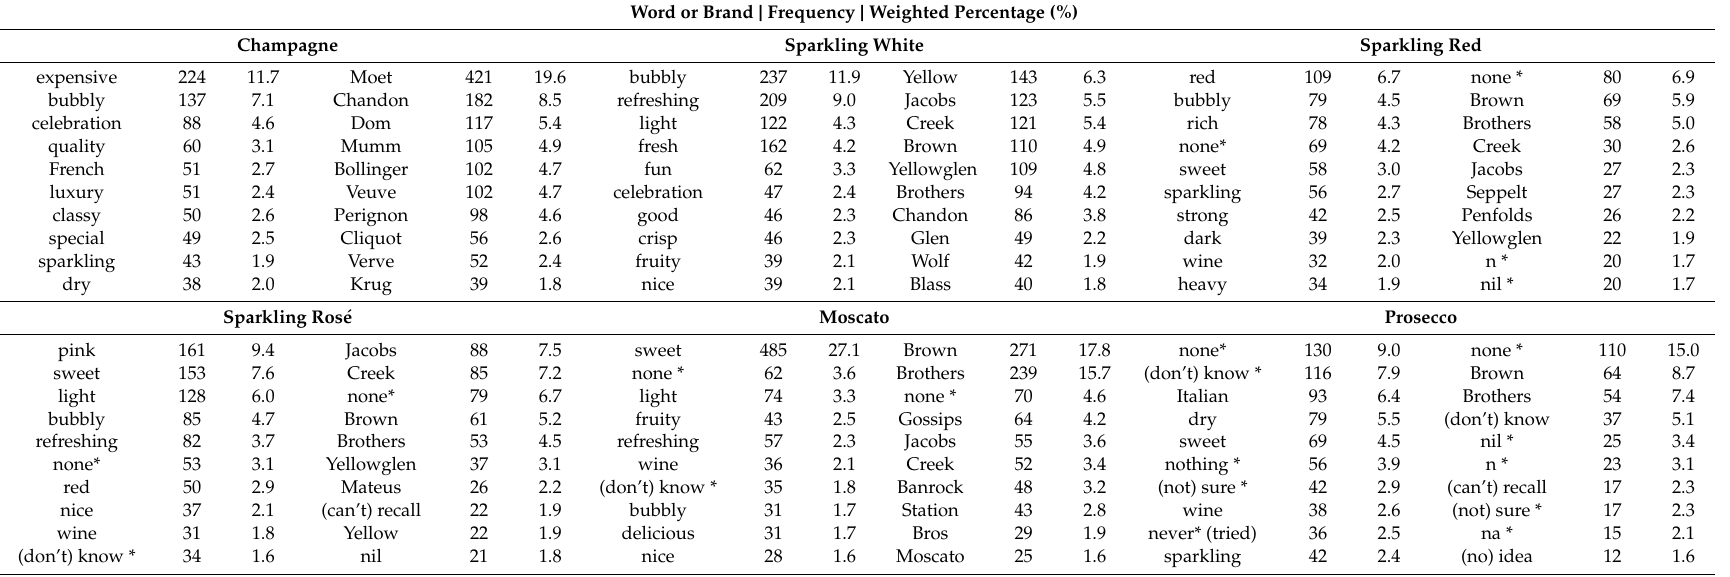
Table 3. Frequencies (and weighted percentages) of the top ten words and brands that consumers associated with di ff erent sparkling wine